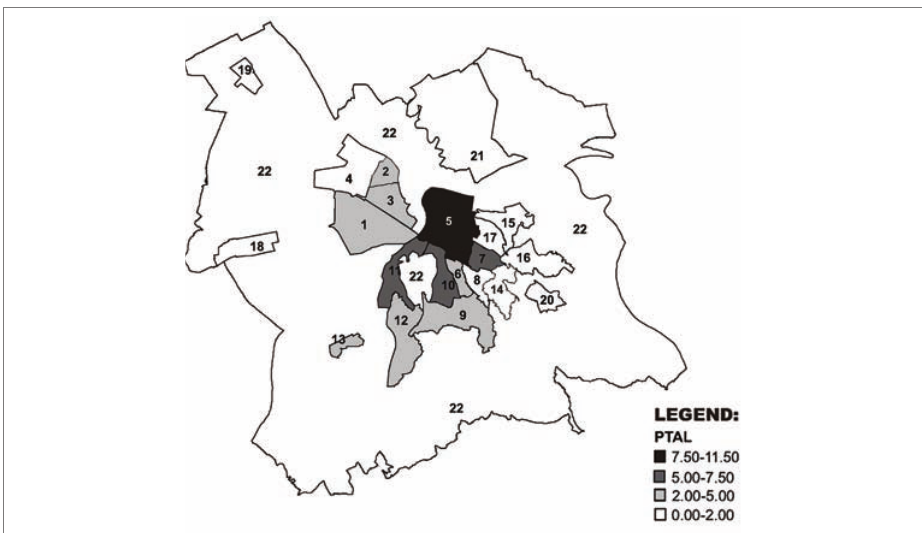
Fig. 2. Ranking of zones covered by the Study according to